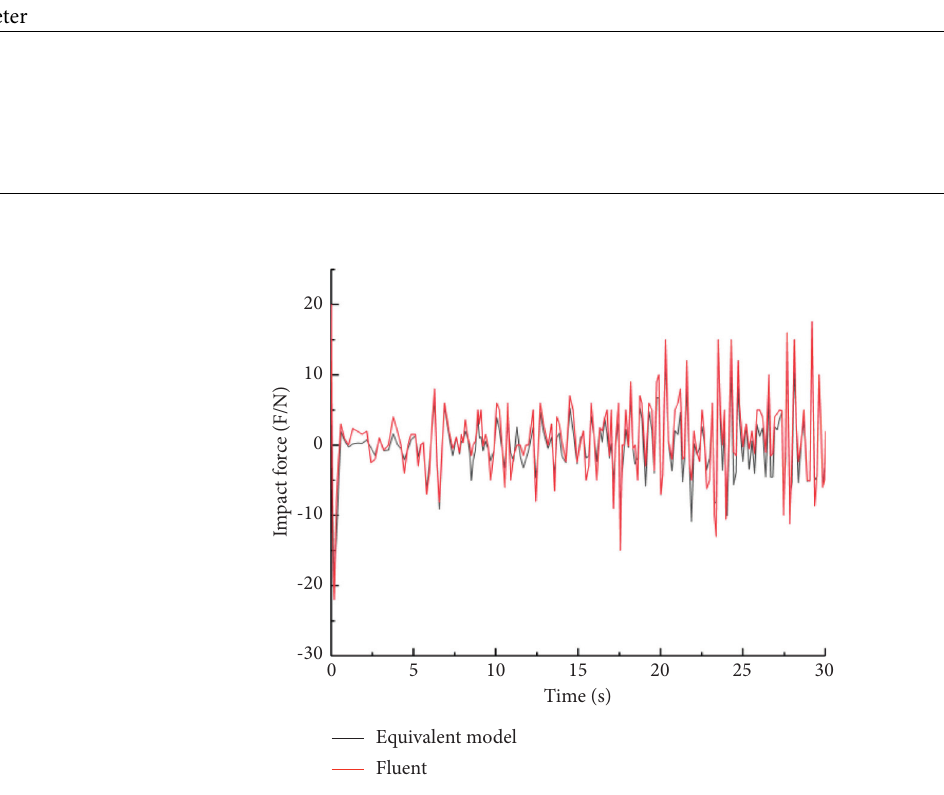
Figure 10: Impact force of liquid